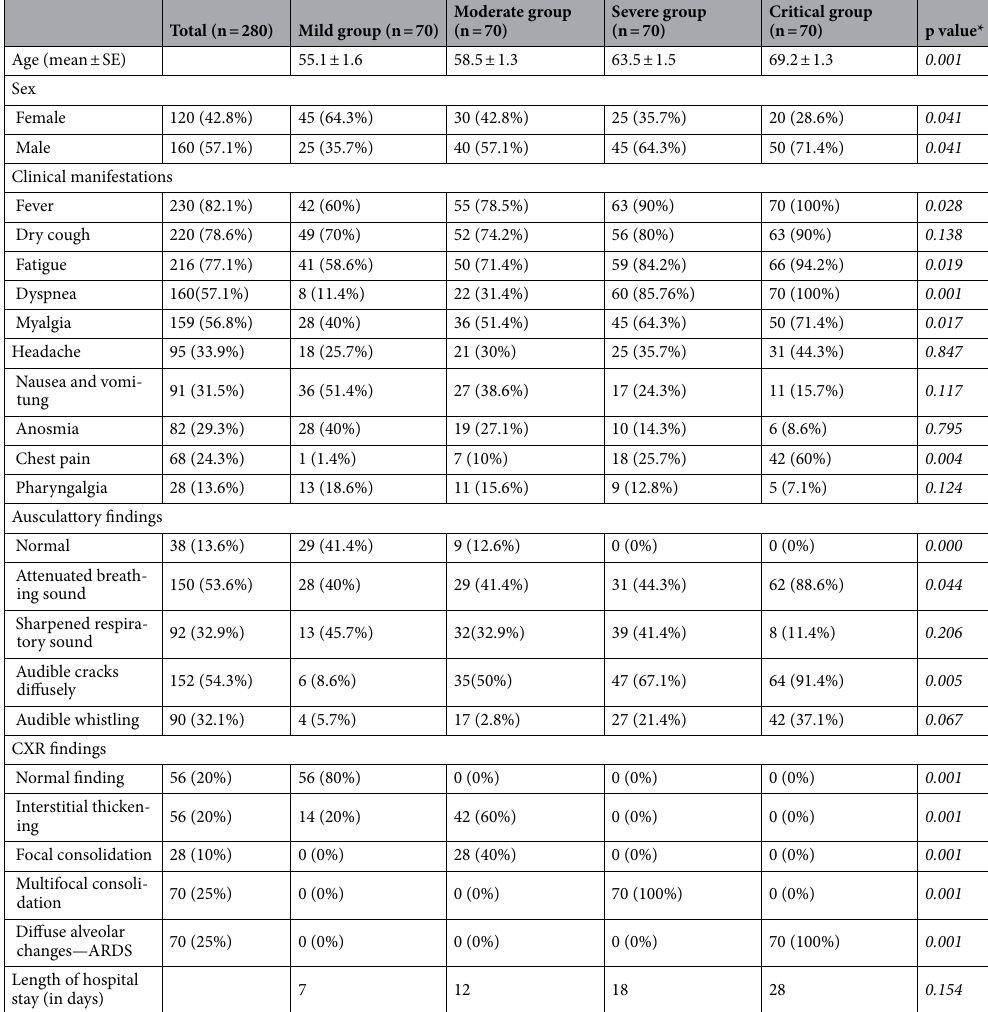
Table 1. Demographics and clinical characteristics of patients with COVID-19. Significant values are in italics. Data expressed as mean, standard error (SR), frequency (percentage). *p values indicate differences between mild, moderate and severe group p < 0.05 was considered statistically